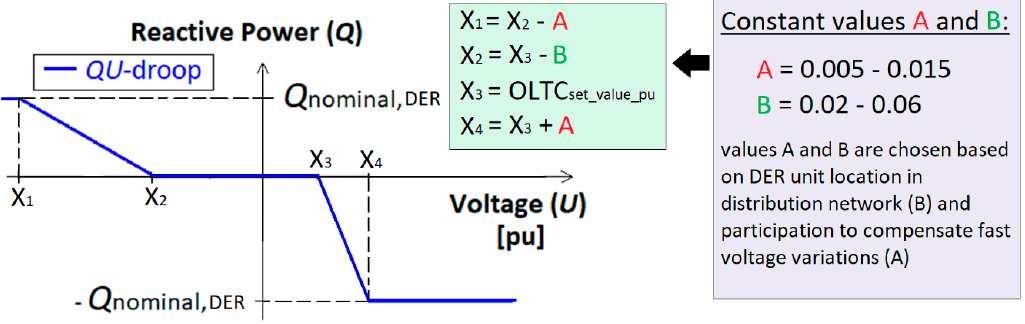
Figure 12. Real-time adaptive DER unit QU -droop based on OLTC set value and constants A and B.